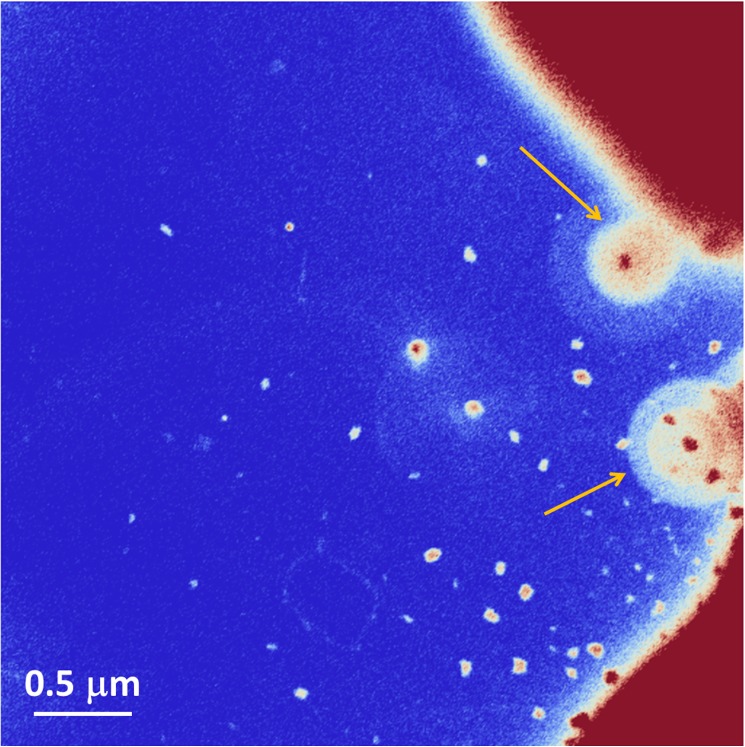
Low magnification High Angle Annular Dark Field STEM image.The smaller spots in the image are nanometric-sized particles surrounding the TS fiber. The arrows in the image point two areas of carbon contamination due to prolonged exposure to the electron probe.